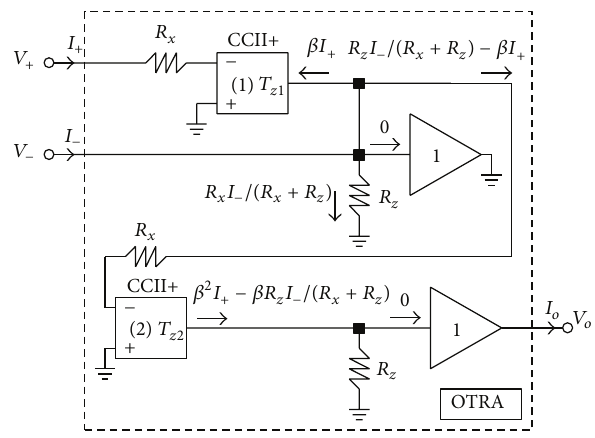
Figure 5: Equivalent circuit model of the OTRA (Figure 3) with nonideal and parasitic